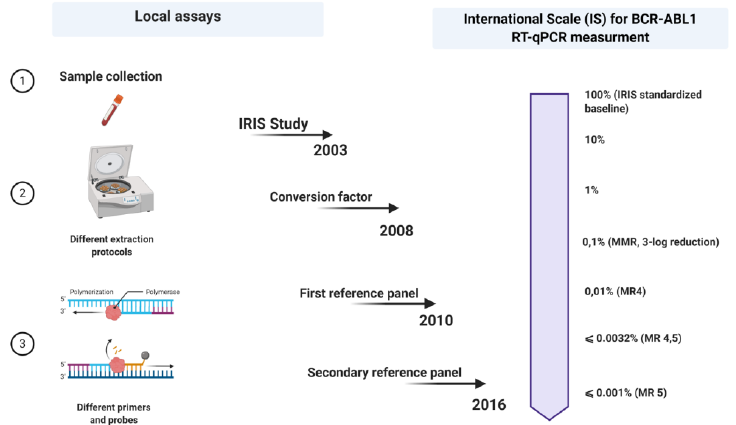
Figure 1. Schematic outline of all steps in the standardization process of p210 BCR-ABL1 transcript monitoring in patients with chronic myeloid leukemia (CML). Each laboratory uses its local assay for quantitative qRT-PCR and then expresses its results on an international scale (IS) using a conversion factor (CF) based on a reference panel (the last reference panel from 2016). Picture created with Biorender.com.